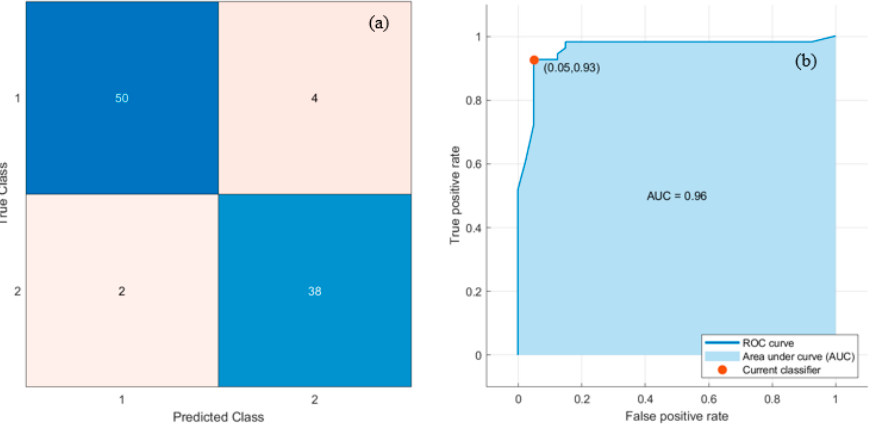
Figure 9. Best results with SVM/DT classifiers: ( a ) Confusion matrix, and ( b ) ROC curve. Six popular performance metrics (Accuracy (Acc), Sensitivity (Sen), Specificity (Spe), Precision (Pre), F1-score (F1), and area under the ROC curve (AUC)) were adopted